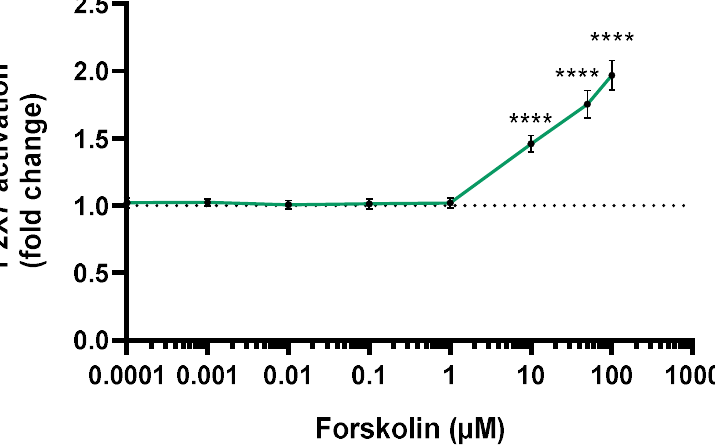
Figure 2. P2X7 receptor activation using the YO-PRO-1 assay after a 72-h incubation time with forskolin. The dotted line represents the P2X7 receptor activation basal level. The significance threshold was **** p < 0.0001 compared to the culture medium.